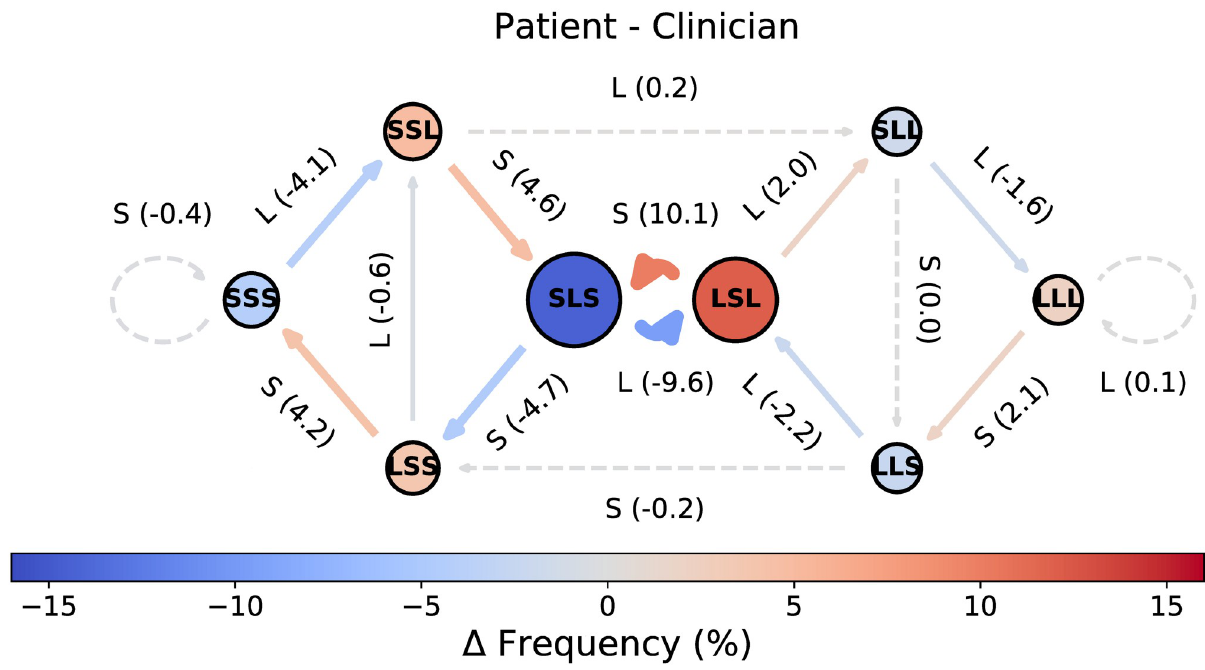
Fig 3. Differences in information flow between patient and clinician turns in the PCCRI corpus. Difference CODYM, where Δ Frequency = (% Observed for Patient) − (% Observed for Clinician). State and transition frequency distributions that are statistically significantly different between patients and clinicians ( P < 0.05 by Mann Whitney U tests) are indicated by outlining states in black solid ( vs . dashed) circles and drawing transition arrows with solid ( vs . dashed)